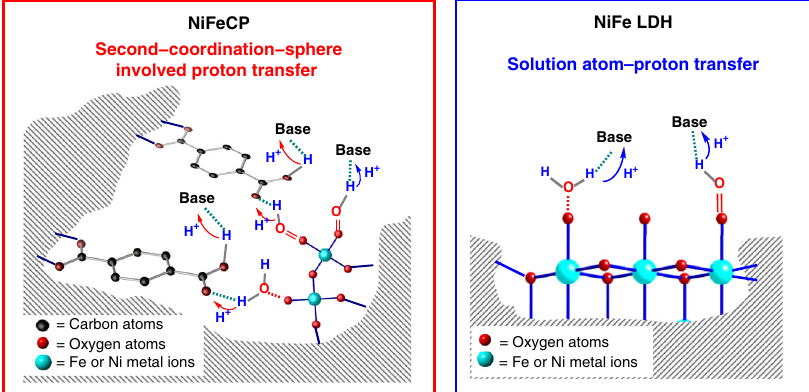
Fig. 8 Schematic illustration of the proposed proton transfer processes: second-coordination-sphere involved proton transfer for NiFeCP (left) and APT for NiFe